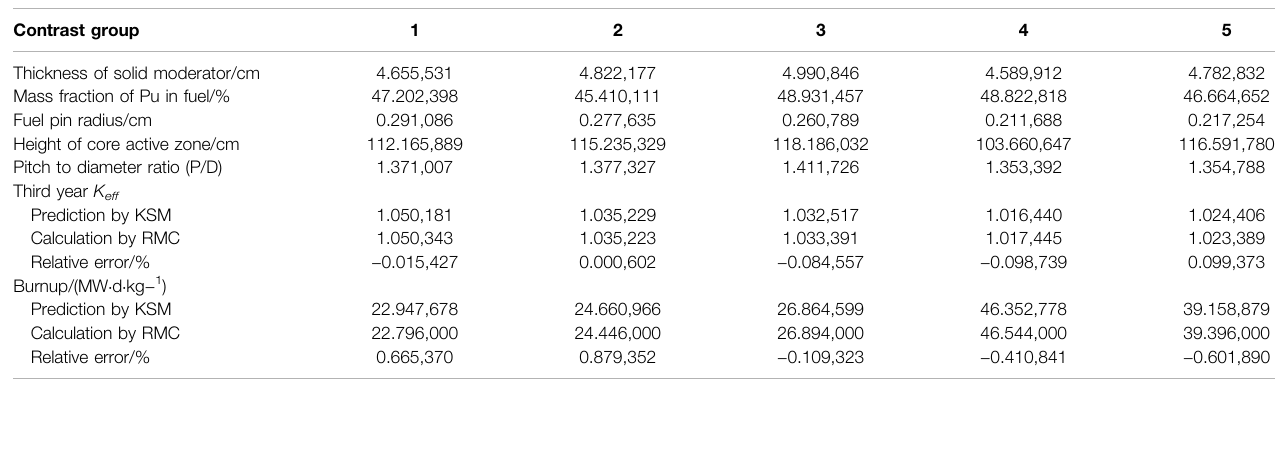
Frontiers in Energy Research |